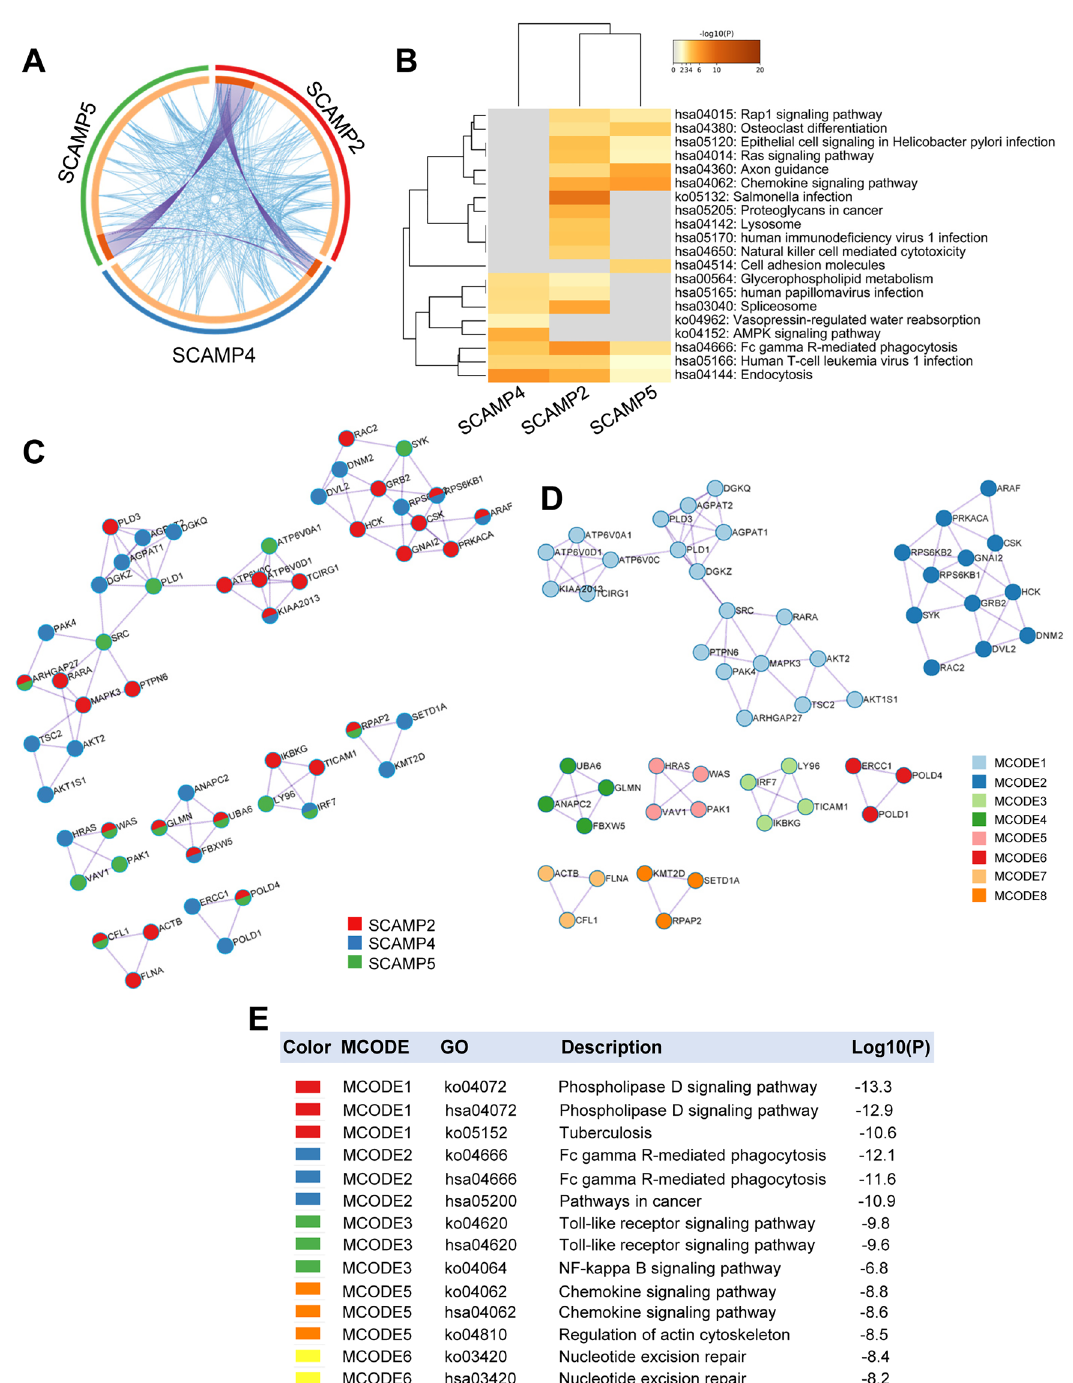
Figure 7. Overlaps, enrichment analysis, PPI network and MCODE analysis of SCAMP2/4/5 and their co-expressed genes in Metascape (Metascape database). ( A ) Circus plot of overlaps among SCAMP2/4/5 and their co-expressed genes. ( B ) Heatmap of enriched terms among SCAMP2/4/5 and their co-expressed genes. ( C ) Protein–protein interaction (PPI) network among SCAMP2/4/5 and their co-expressed genes. ( D ) MCODE components were identified in PPI network among SCAMP2/4/5 and their co-expressed genes. ( E ) Five MCODE components list in PPI network among SCAMP2/4/5 and their co-expressed